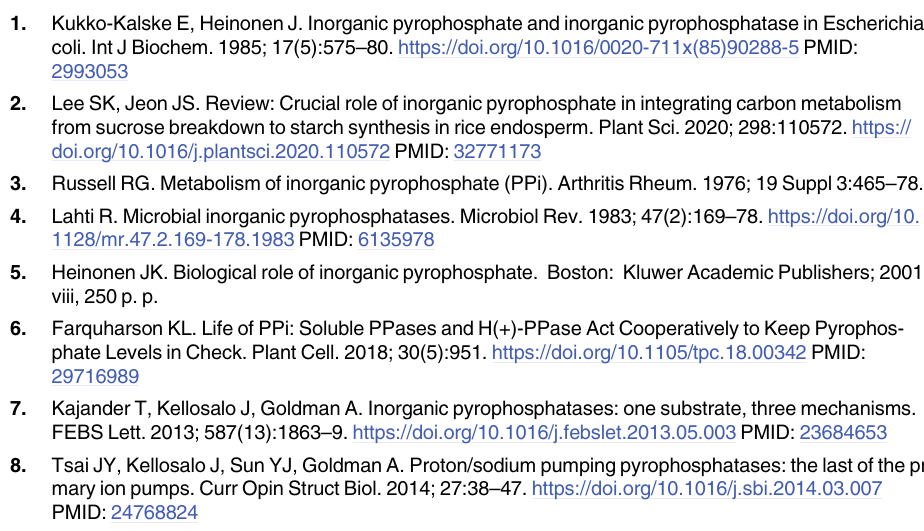
S1 Table. Plasmids used in this study. S2 Table. Primers used in this study. S3 Table. Statistical analysis results of datasets used in Figs 5 and